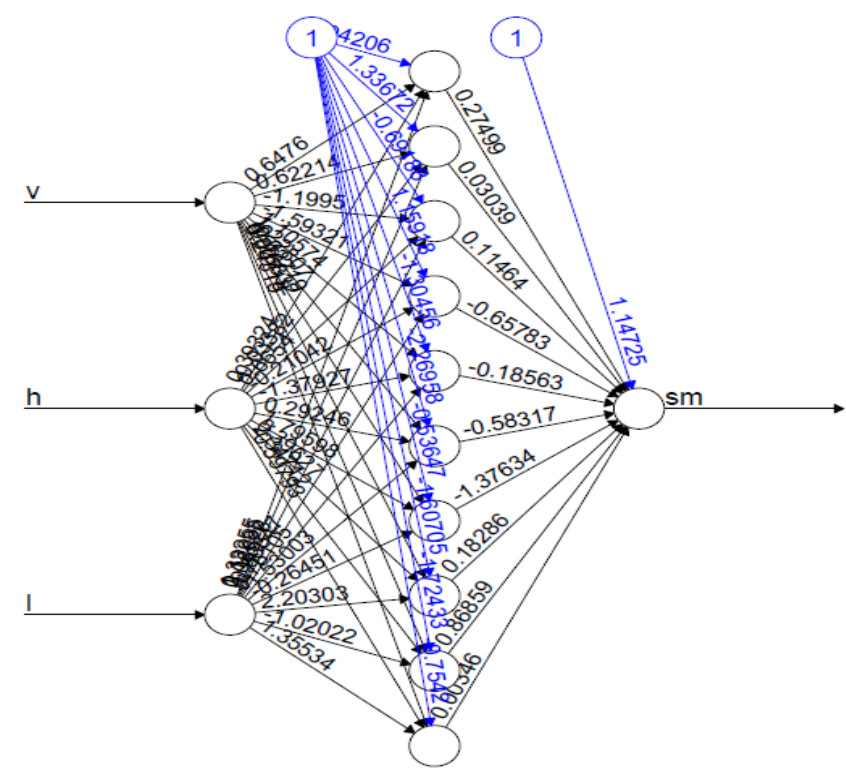
Figure 4. Artificial neural network (ANN) architecture used for soil moisture estimation using v- σ soil _ vv , h − h rms and l − l ef f as input variables and soil moisture (sm) as the output variable. The structure has one hidden layer and 10 hidden neurons.